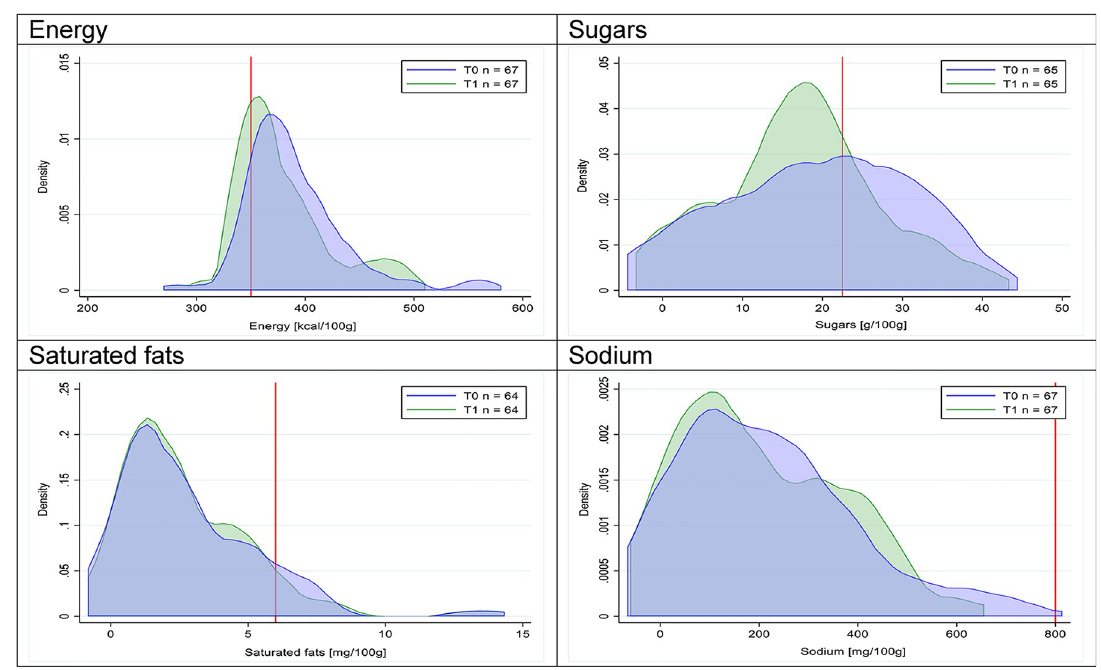
Fig 21. Density curves for the amount of energy and nutrients of concern in breakfast cereals, longitudinal subsample. The blue line represents the distribution in T0 (preimplementation), the green line represents the distribution in T1 (postimplementation), and the red line represents the cutoff for the amount of energy or nutrients of concern.